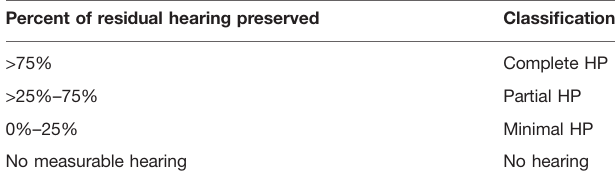
TABLE 1 | Scale of HP classi fi